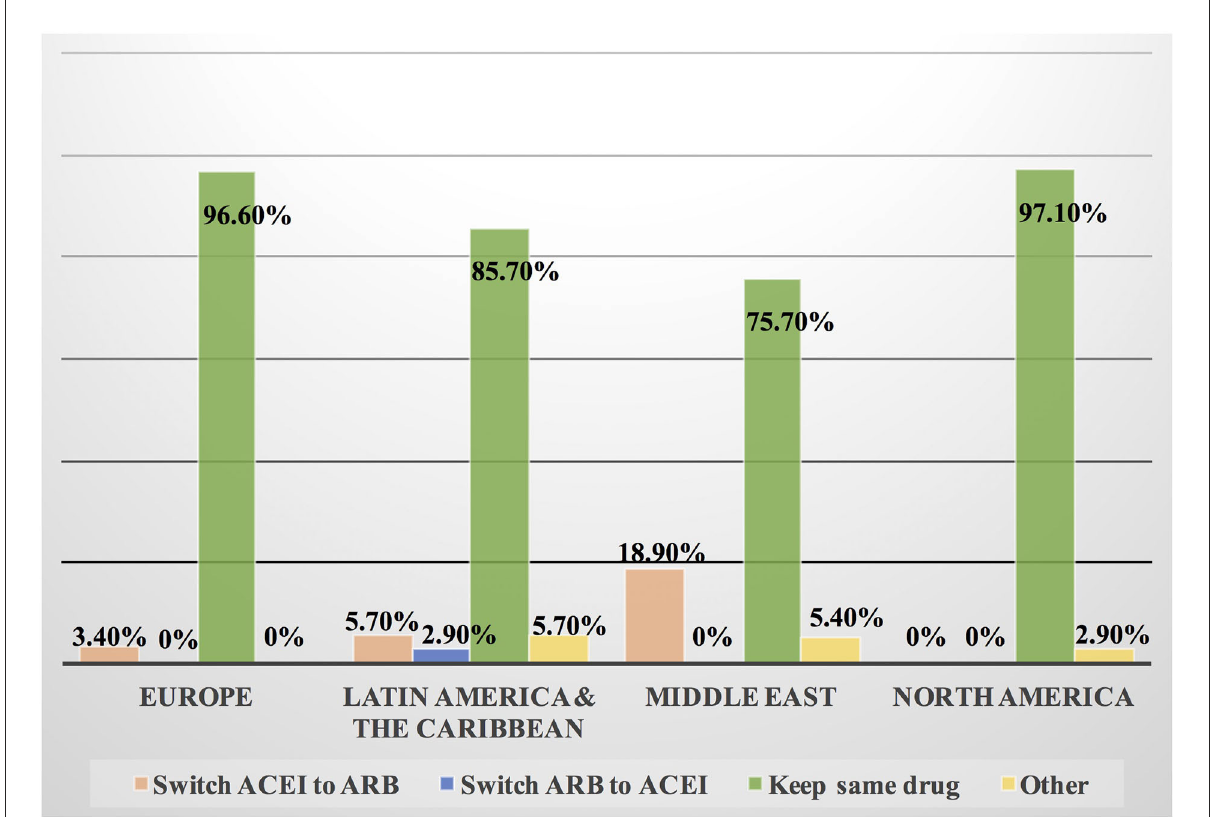
FIGURE10 Switching between ACEI and ARB among patients with cancer and COVID-19 infection in different continents. Some cardiologists and oncologists switched ACEI to ARB during the COVID-19 pandemic, mainly in the Middle East, Latin America and the Caribbean. However, most of the respondents kept patients on the same drug whether ACEI or ARB. ACEI, angiotensin-converting enzyme inhibitor; ARB, angiotensin receptor